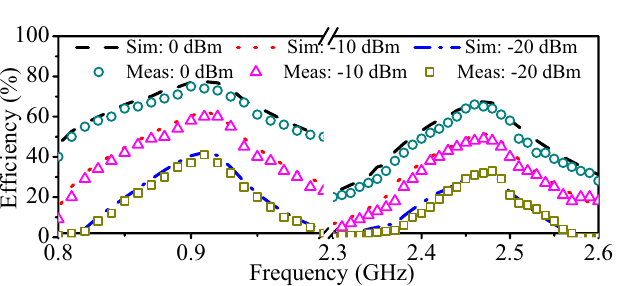
Figure 4. RF-to-DC efficiency at different input powers (0 dBm, −10 dBm, −15 dBm) against operating